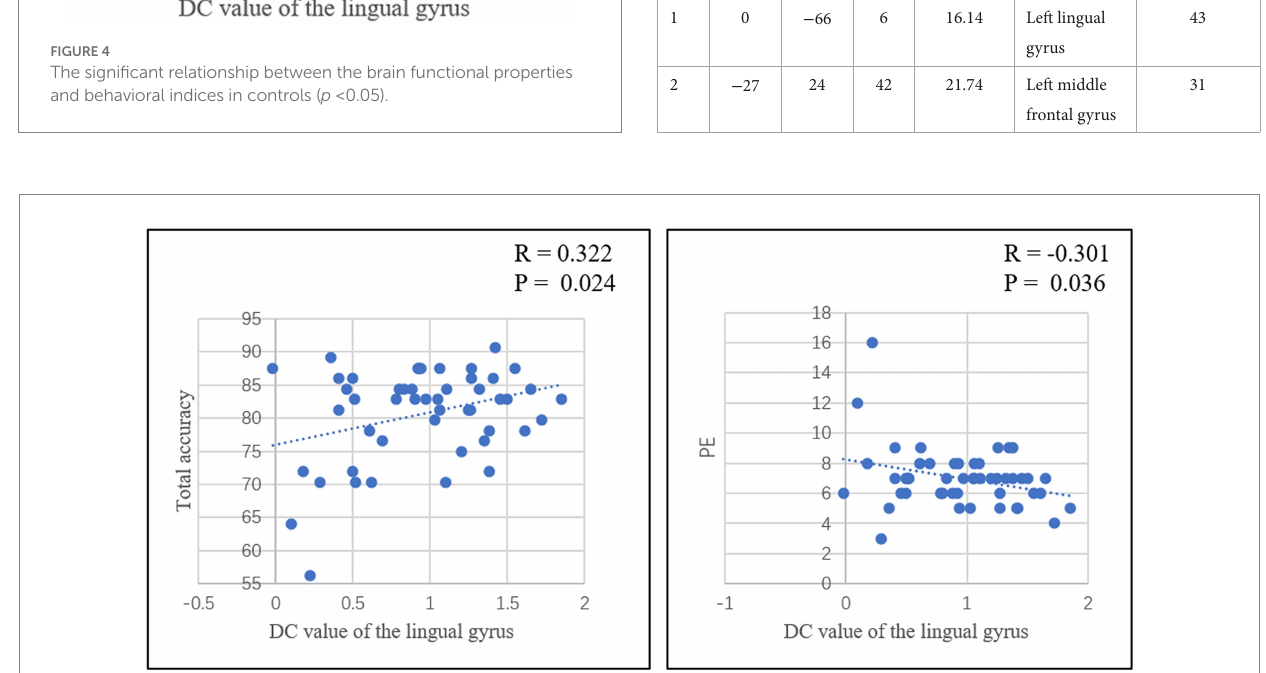
FIGURE 5 The significant relationship between the brain functional properties and behavioral indices in the combined groups of the two groups ( p <